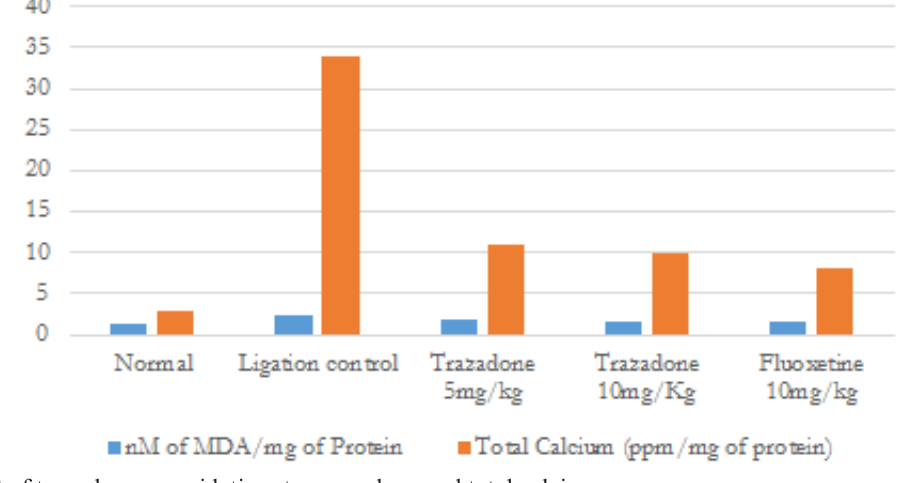
FIGURE 5 - Effect of trazodone on oxidative stress markers and total